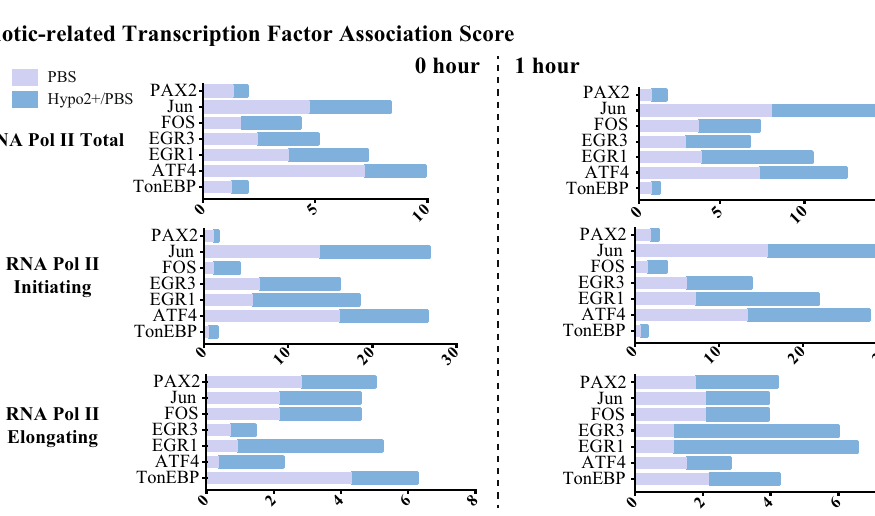
Figure 4. Impact of hyposmotic modulation in RNA Pol II binding profile and transcription. ( A ) Total number of ChIP-Sequencing peaks detected after background noise subtraction, done in K562 cells. ( B ) and ( C ) Relevant transcription factors association scores. Association scores were computed with PASTAA (http://trap. molgen.mpg.de/cgi-bin/pastaa.cgi) as an in silico approach to infer the binding/affinity of transcription factors involved in the regulation of genes enriched in the ChIP-Seq assays for the different forms of RNA Pol